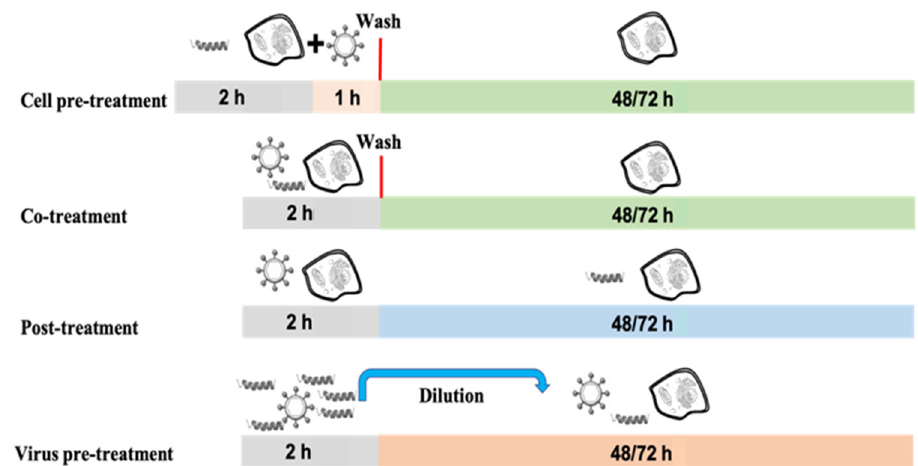
Figure 2. Four experimental schemes to study the virus pretreatment and the cell pretreatment, co-treatment, and post treatment effects of the TL-based peptides on viral infectivity. For cell pretreatment, each peptide was incubated with cells for 2 h, media was then removed, and virus inoculum added and incubated for 60 min, then inoculum was removed and replaced with fresh medium and cells were incubated. For virus pretreatment, the virus was incubated with peptide for 2 h then diluted to obtain ineffective peptide concentrations and added to cells. Cotreatment wells received compound and virus inoculum simultaneously, incubated for 2 h, then media was replaced, and cells were incubated. Post treatment wells were infected with virus for 2 h followed by inoculum removal and replacement with peptides in the media. In each experiment cells were incubated with fresh medium containing CMC from 48 to 72 h (depending on the virus used) and plaques were scored.